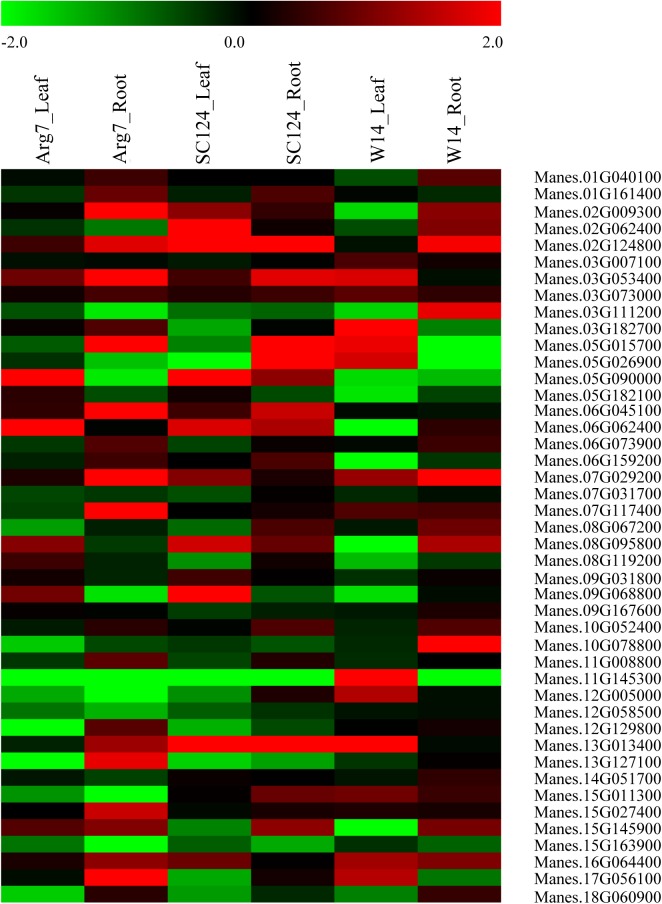
Expression profiles of associated genes in cassava.Log2 based FPKM change fold values drought stress plants by respective control value were used to create the heat map. The differential expression thresholds of significant up and down regulation were set to 2.0 and -2.0 respectively.